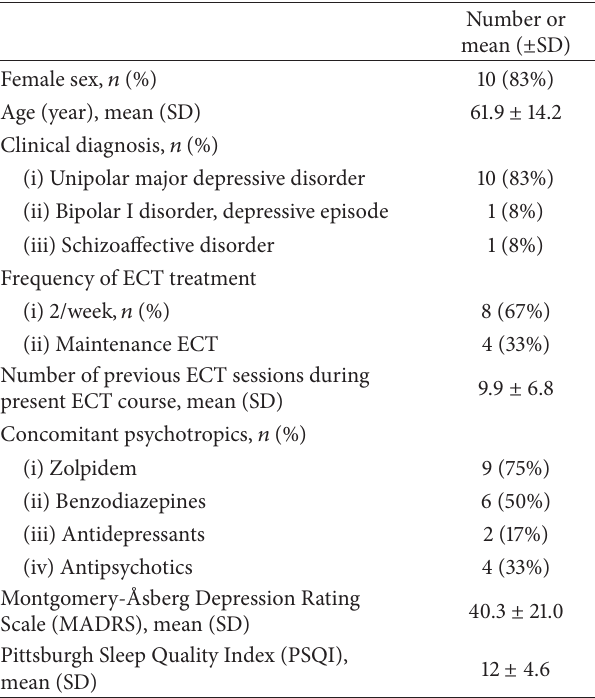
Table 1: Baseline sociodemographic and clinical characteristics of 12 patients undergoing